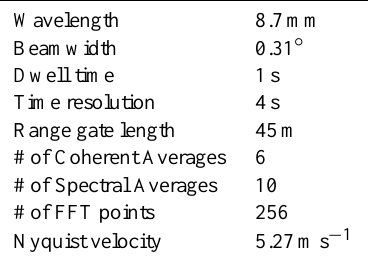
Table 1. MMCR specifications for the “stratus” operational